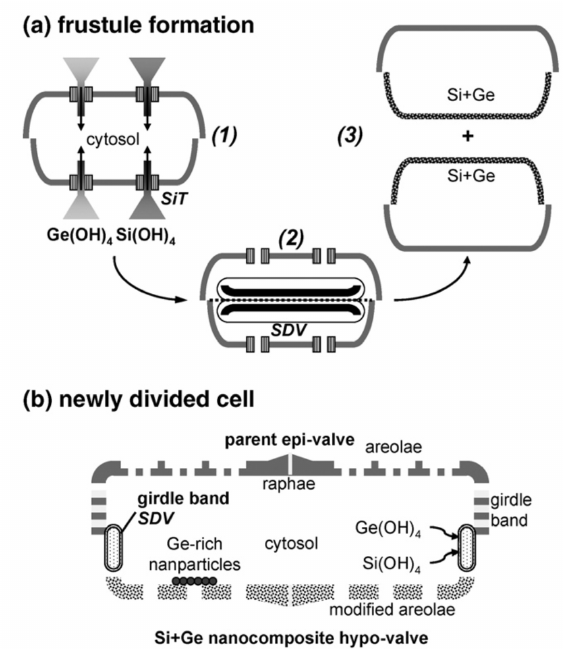
Figure 3. ( a ) Conceptual scheme for metabolic insertion of germanium into a diatom frustule: (1) uptake of Si and Ge by Si transporters (SITs); (2) valve development within the silica deposition vesicle (SDV); (3) cell division. ( b ) Simplified representation of the frustule of the newly-divided cell, showing intracellular Ge located in the new hypo-valve, Ge-rich nanoparticles, and the developing girdle band. Reproduced with permission from Ref.